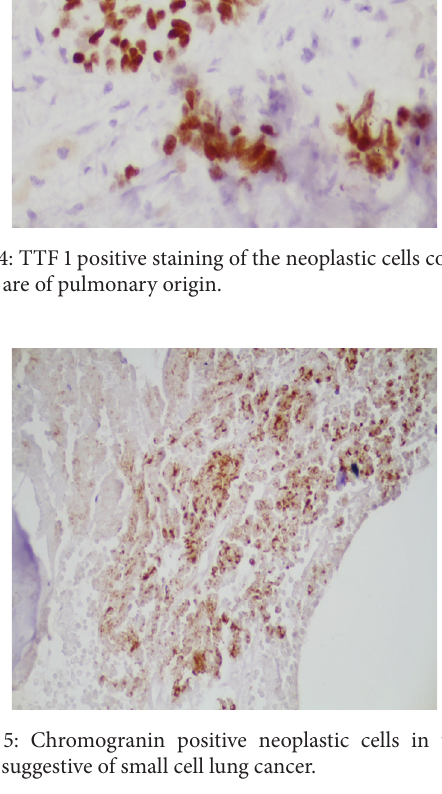
ACTH syndrome. There was no evidence of tumor lysis syndrome. Eventually the patient’s hemoglobin and WBC counts also dropped but to a very less extent with nadir being only 10 gm/dL and 4000/ 𝜇 L, respectively.